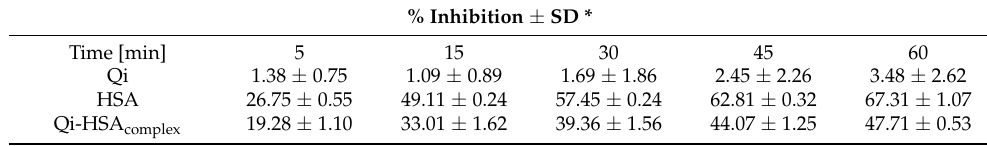
Table 5. The value of % inhibition of Qi ([Qi] = 6.67 × 10 − 5 M), HSA ([HSA] = 1 × 10 − 5 M), and Qi-HSA complex (1:6.67 molar ratio; [Qi] = 6.67 × 10 − 5 M; [HSA] = 6.67 × 10 − 5 M; ABTS assay); pH = 7.4).